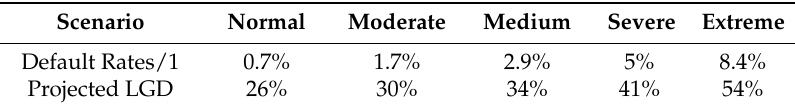
Table A1. Stress levels of default rates and LGDs for advance